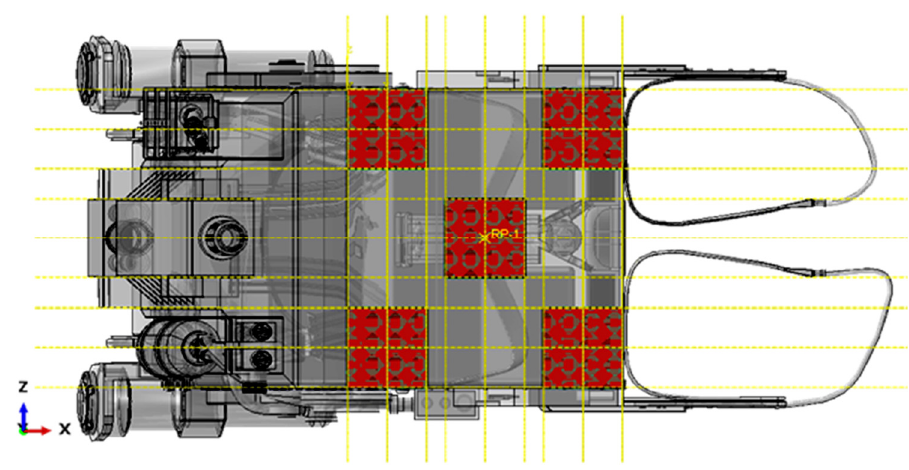
Figure 7. K-39 LT—Shock absorbers system integration—bottom view.